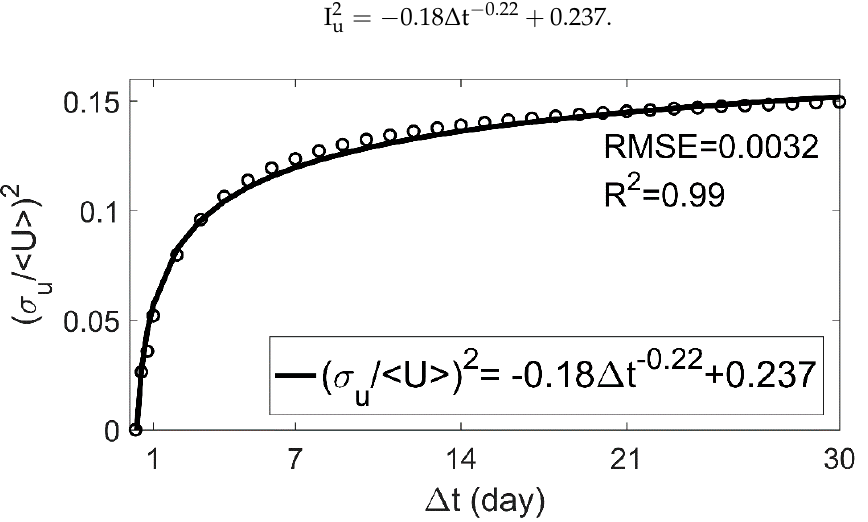
Figure 8. Coefficient of variation I 2 u as a function of the averaging period ∆ t (from 6-hourly to monthly). Circles indicate the results from measurements, and the solid line represents a modelled fit through the measurements. For ∆ t > 18 days, I u2 becomes independent of ∆ t. Global climate models operate on a ∆ t = 30 days.